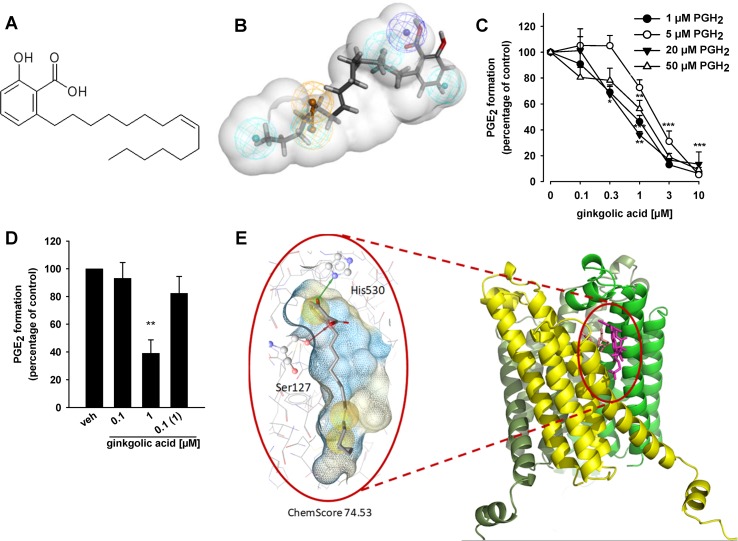
Ginkgolic acid (GA) targets mPGES-1 activity. (A) Chemical structure of ginkgolic acid (GA). (B) GA mapped to the pharmacophore model M2 for acidic inhibitors of mPGES-1 (Bauer et al., 2012). It mapped the negatively ionizable feature (dark blue) and the four hydrophobic features (cyan), while the aromatic ring feature (brown) was omitted. (C) Inhibition of mPGES-1 activity; concentration–response analysis. Microsomal preparations of IL-1β-stimulated A549 cells were pre-incubated with GA or vehicle (0.3% DMSO) for 15 min at 4°C and PGE2 formation was induced by addition of PGH2 at 1, 5, 20, or 50 µM, as indicated. The amount of PGE2 was quantified for 1 and 5 µM PGH2 by the use of a PGE2 High Sensitivity EIA Kit (Abcam, Cambridge, UK) according to the manufacturer’s protocol, and PGE2 formation of samples incubated with 20 and 50 µM PGH2 was analyzed by RP-HPLC. Data are given as mean ± S.E., n = 3, *p < 0.05, **p < 0.01, ***p < 0.001 vs. vehicle (DMSO) control, ANOVA + Tukey HSD post hoc tests. (D) Reversibility of mPGES-1 inhibition. Microsomal preparations were pre-incubated for 15 min with 1 µM GA or vehicle (DMSO), and an aliquot was diluted 10-fold to obtain an inhibitor concentration of 0.1 µM. Then, 20 µM PGH2 was added and all samples were incubated for 1 min on ice, and PGE2 formation was analyzed as described by RP-HPLC. Data are given as mean ± S.E., n = 3, **p < 0.01 vs. vehicle (DMSO) control, ANOVA + Tukey HSD post hoc tests. (E) GA fitted into the binding site of mPGES-1, located between two monomer units (yellow and green), in a molecular docking simulation. The chemical interactions are color-coded: yellow spheres, hydrophobic; red arrow, hydrogen bond acceptor; green arrow, hydrogen bond donor. The surface is colored by aggregated hydrophilicity (blue)/hydrophobicity (gray). Amino acids participating in hydrophilic interactions are depicted in ball-and-stick style.